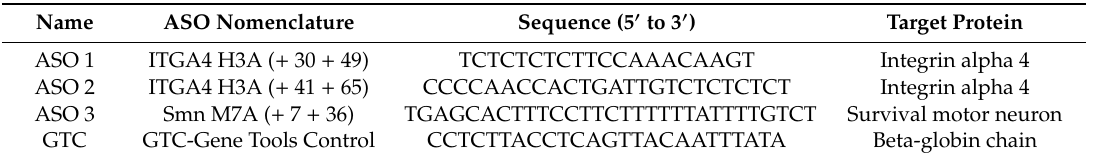
Table 2. Information for